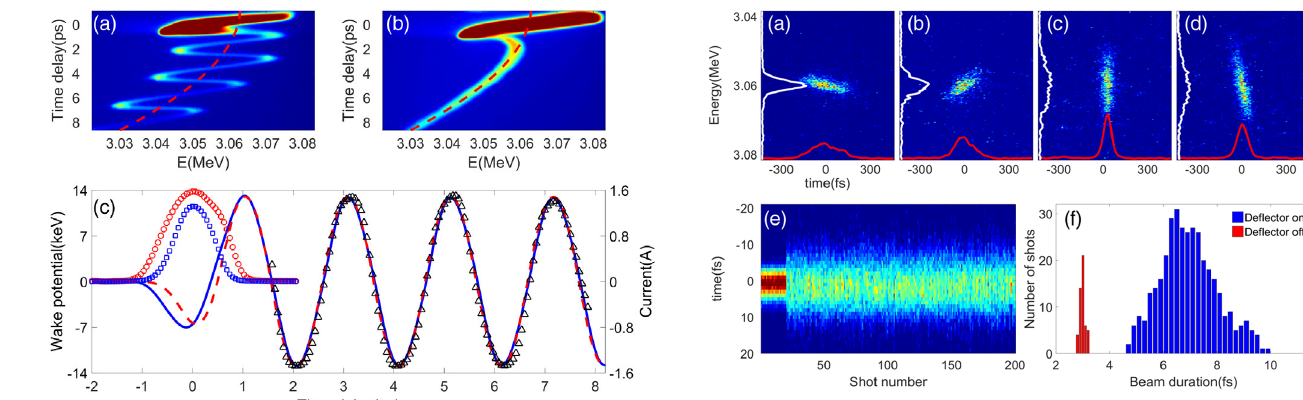
FIG. 3. Longitudinal phase space (bunch head to the left) of the witness beam when the charge of the drive beam is changed from 0 (a) to 0.6 pC (b), 0.9 pC (c), and 1.3 pC (d). The corresponding temporal profile (red line) and energy distribution (white line) are also shown. (e) 200 consecutive measurements of the witness beam temporal profile with rf deflector off (the first 20 shots) and on (the rest 180 shots). (f) Distribution of the raw bunch length collected over 50 consecutive shots with deflector off and 400 consecutive shots with deflector